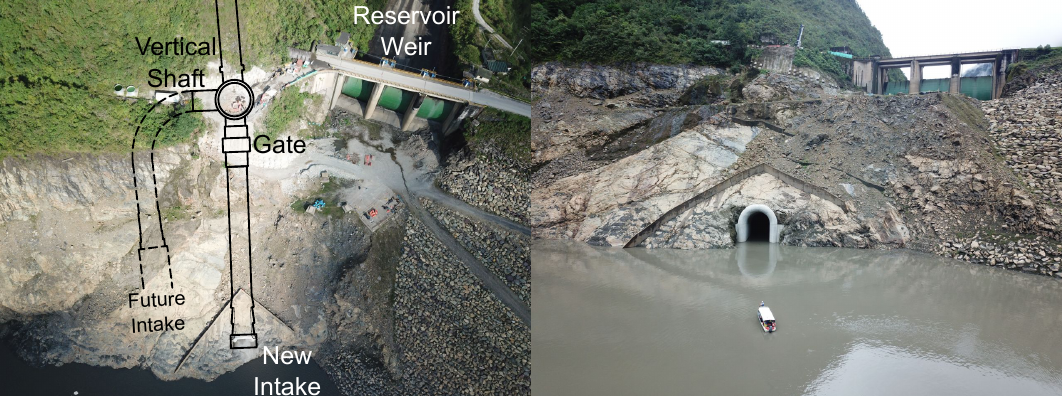
Figure 10. Chivor new intake system. Details are shown for the intakes and the gate connection with the vertical shaft.